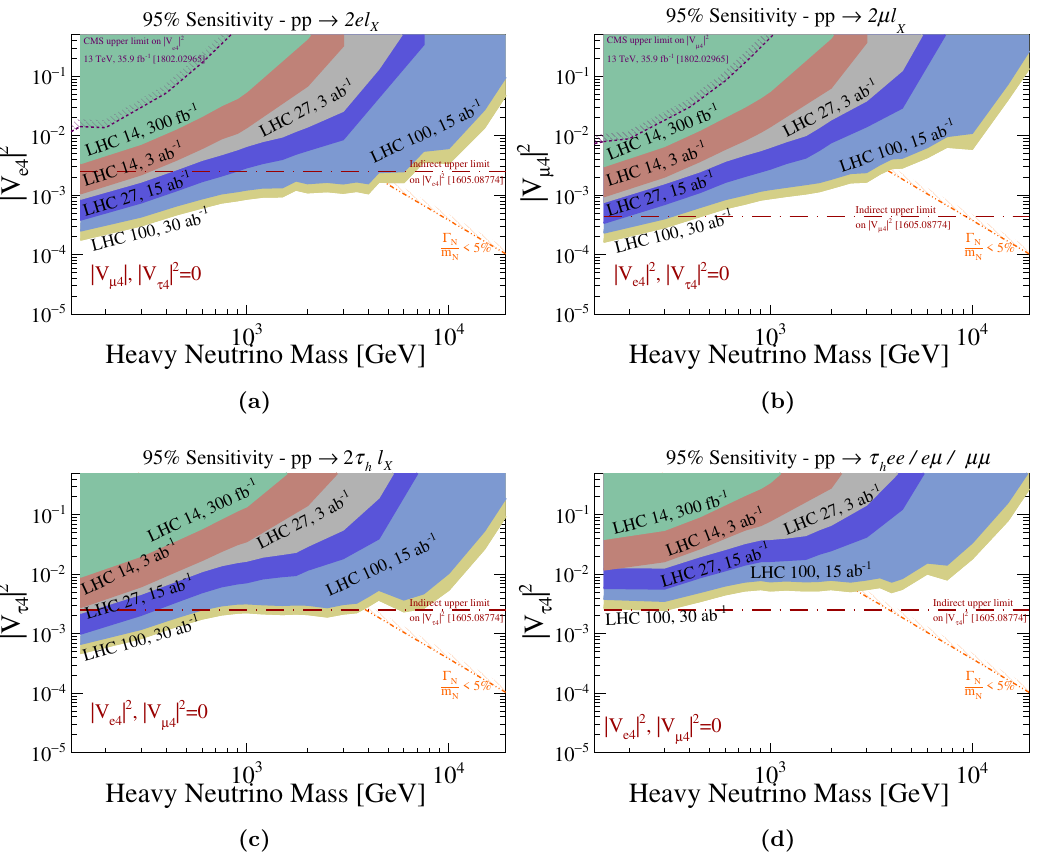
Figure 26. Same as (cid:12)gure 25 but for the charged lepton (cid:13)avor conserving signal categories (a) EE , (b) MUMU , (c) TAUTAU-I , and (d) TAUTAU-II as de(cid:12)ned in table